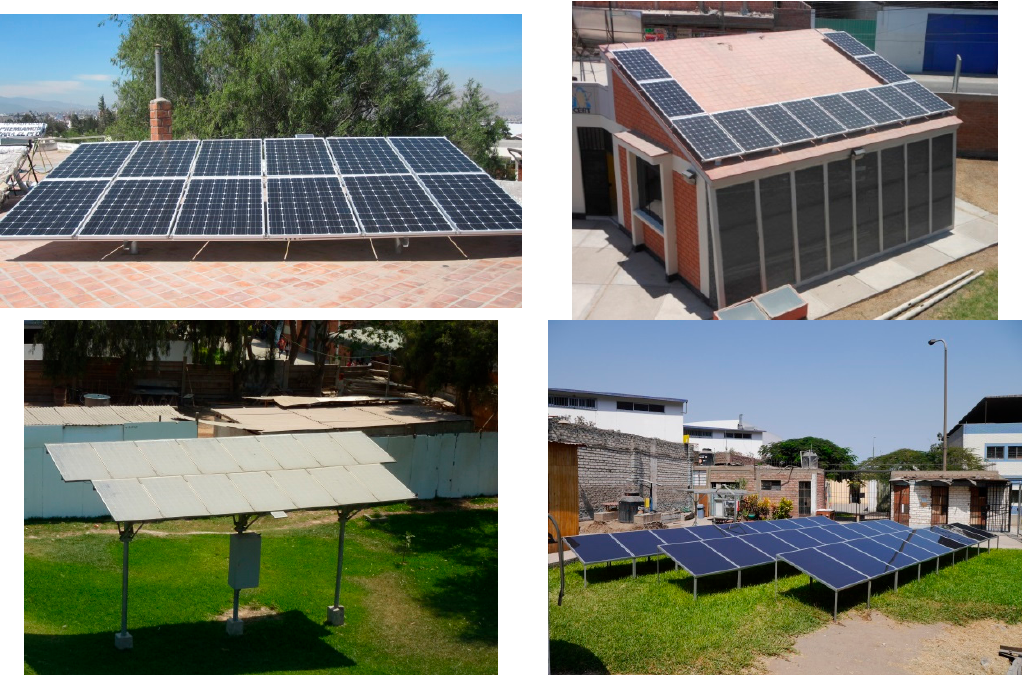
Figure 1. Photographs of the PV systems under investigation. ( Top left ) PVGCS #1 in Arequipa (sc-Si, installation on flat roof); ( top right ) PVGCS #2 in Tacna (sc-Si, building integrated installation); ( bottom left ) PVGCS #2 in Lima (mc-Si, on-ground installation); ( bottom right ) PVGCS #4 in Lima (a-Si/µc-Si, on-ground installation).